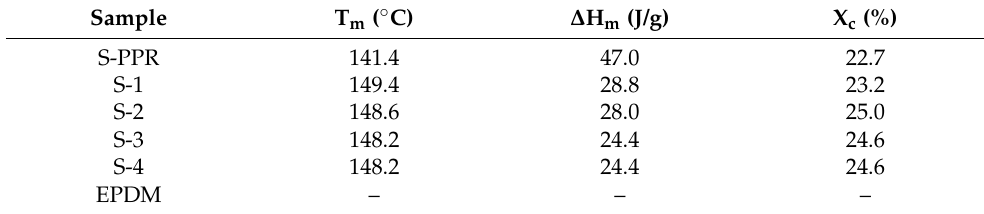
Table 4. Summary of thermal properties of various materials via